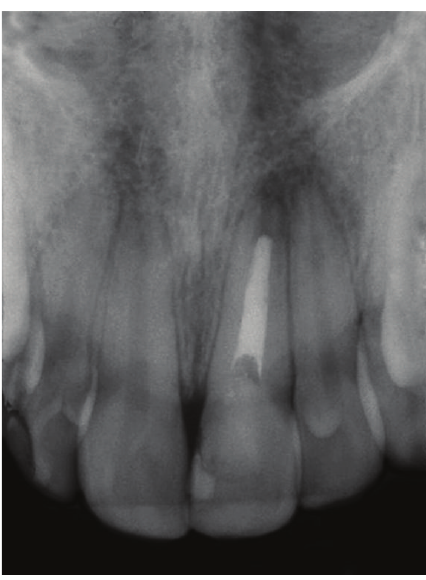
Figure 1: Radiographic view of the fractured